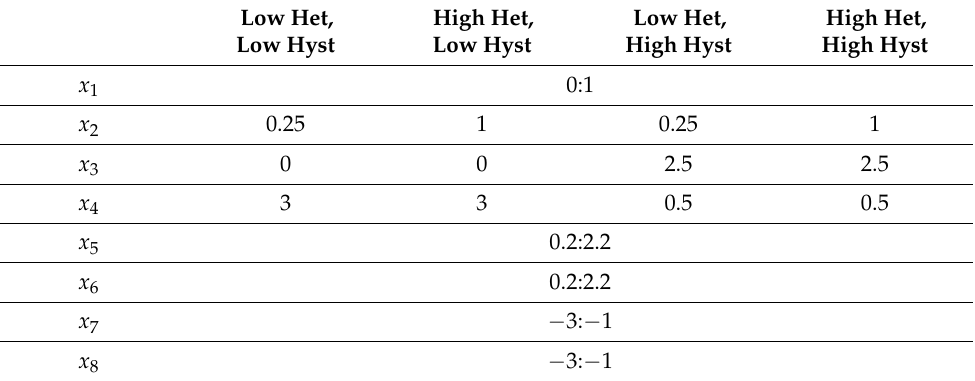
Table 5. Parameter selections for MOD2, where oil viscosity is varied and influences mobility ratios and gravity numbers. Four cases are considered according to heterogeneity and